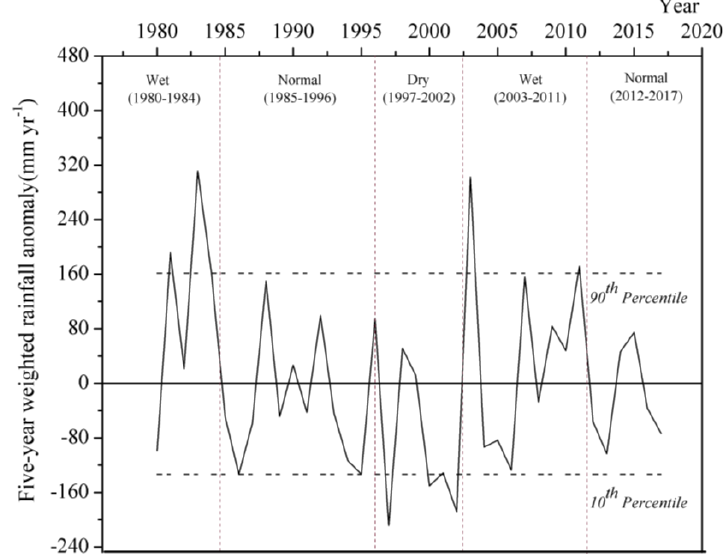
Figure 3. Weighted rainfall anomaly (5 year) for the Jinghuiqu irrigation region with respect to long-term rainfall anomaly (1980–2017). 90th percentile and 10th percentile showing extreme wet years and extreme dry years as dashed horizontal lines.